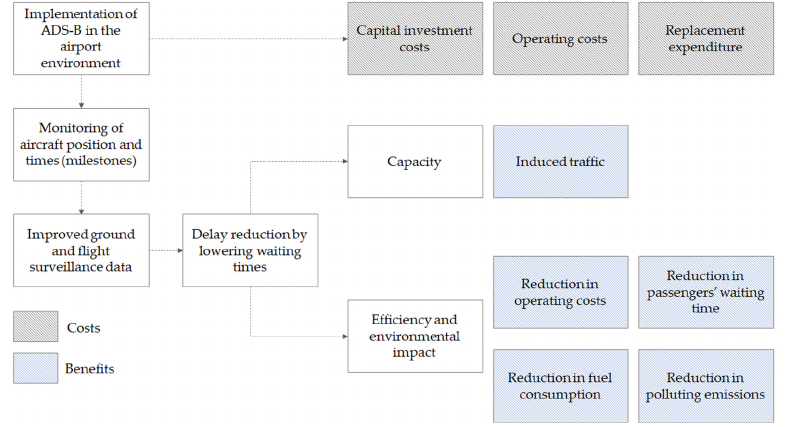
Figure 16. Costs and benefits derived from the implementation of ADS–B technology in